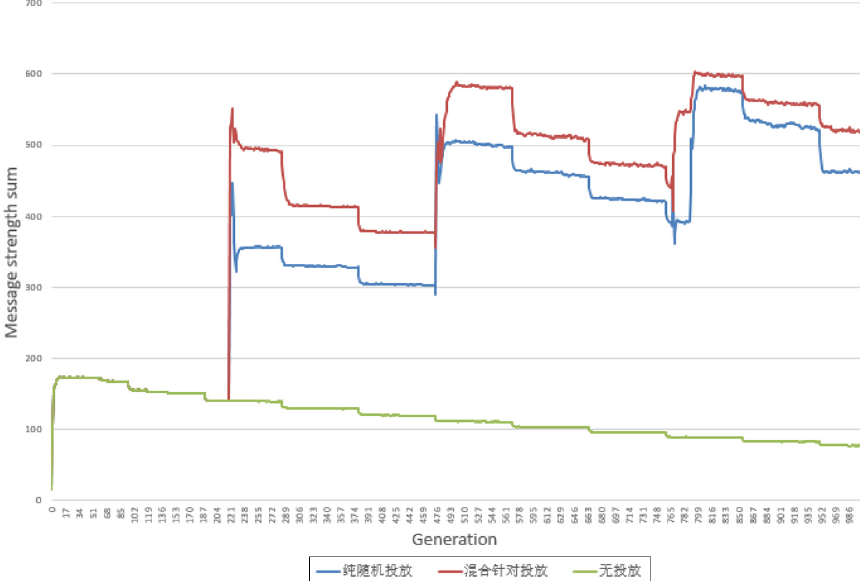
Figure 4. Simulation